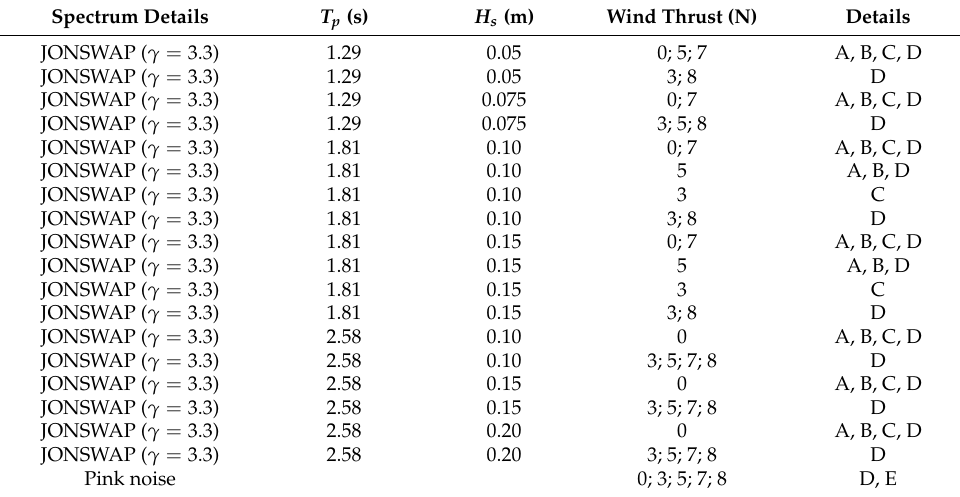
Table 2. Irregular wave list at model scale.